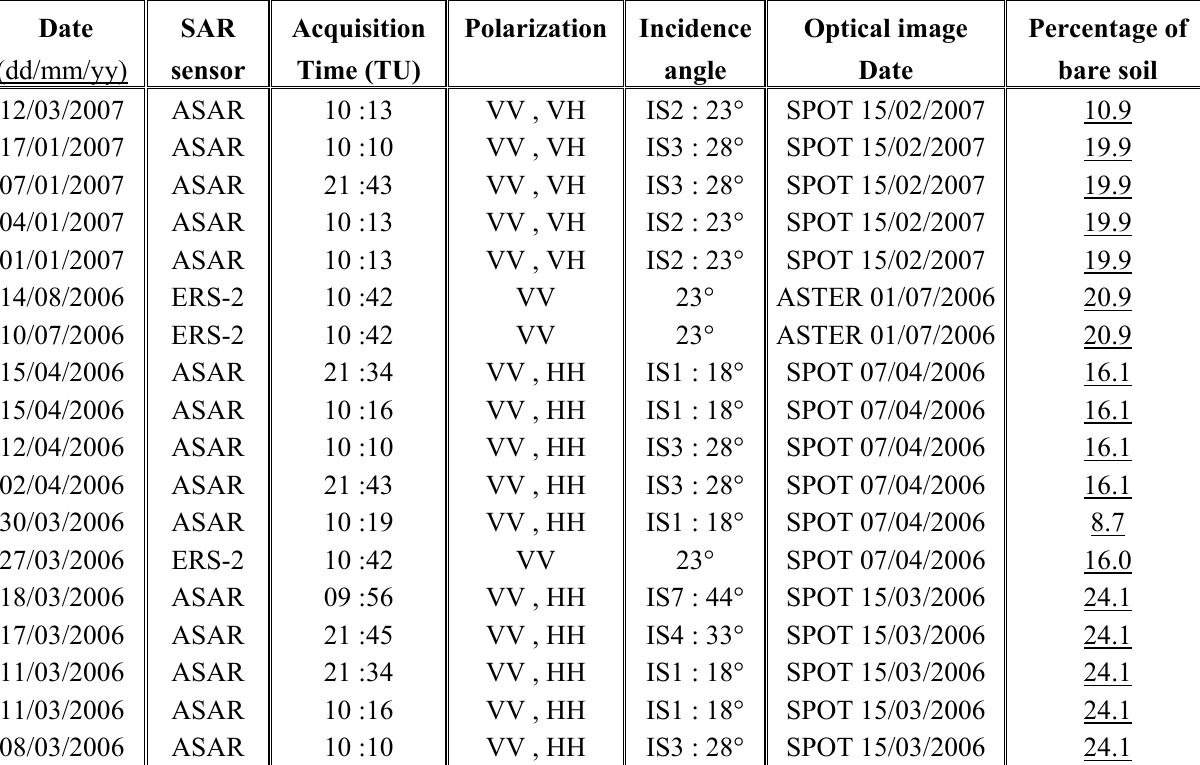
Table 1. Main characteristics of SAR images used for soil moisture mapping. Images are acquired over the Touch basin in 2006-2007. For each SAR date, there are the optical images used for mapping bare soils. 33 gravimetric measurements were performed on March 12,